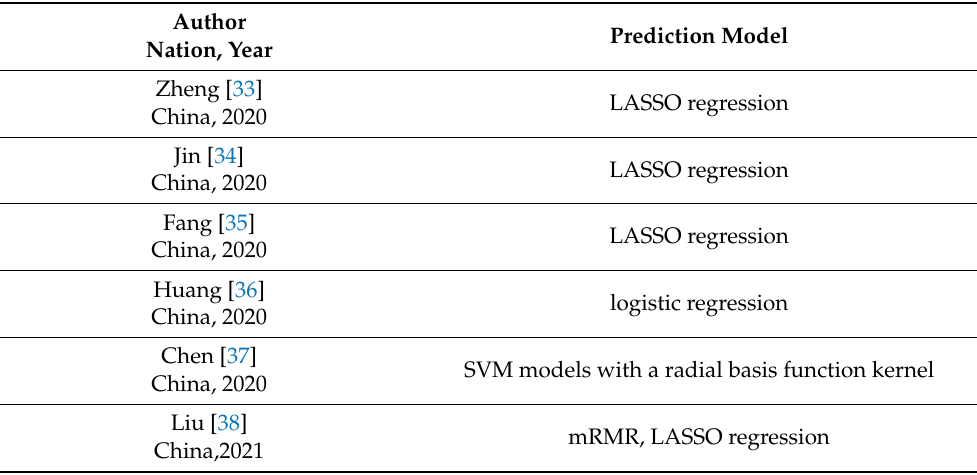
Table 4. Prediction models used in the collected